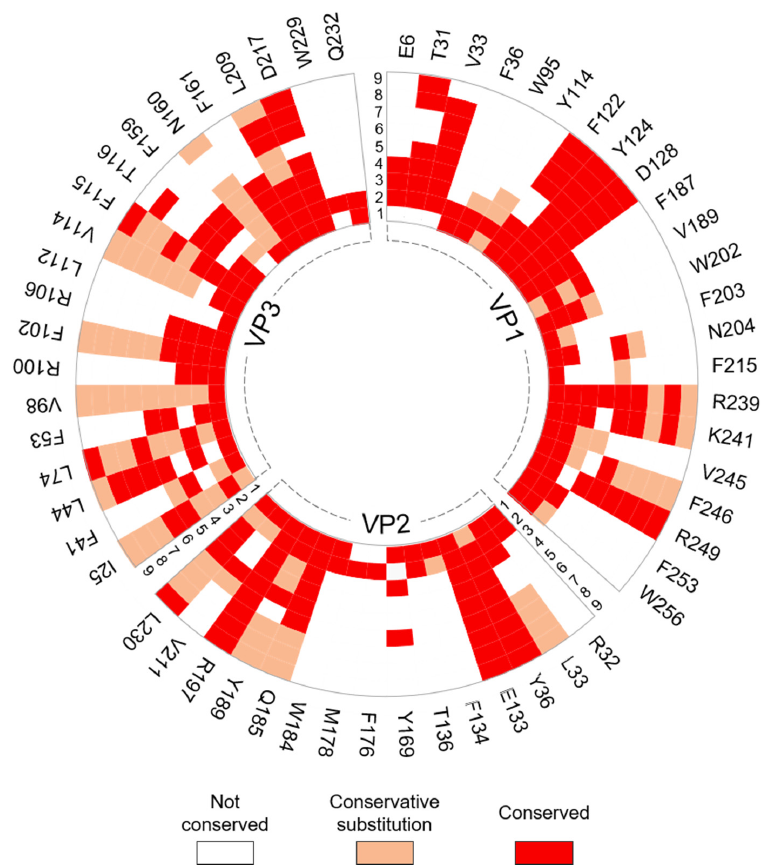
Figure 4. Radial map of the conservation of TMEV intraprotomer residues identified as hotspots across respective picornavirus species. The individual TMEV capsid proteins were submitted to ENDScript2 for conservation analysis. The degree of conservation for each TMEV hotspot was compared in nine representative picornaviruses across four genera. Identity of viruses: 1) Cardiovirus B (SAFV; PDB: 5CFC / 5A8F); 2) Cardiovirus A (EMCV; PDB: 2MEV); 3) Senecavirus (SVV-1; PDB: 3CJI); 4) Equine Rhinitis